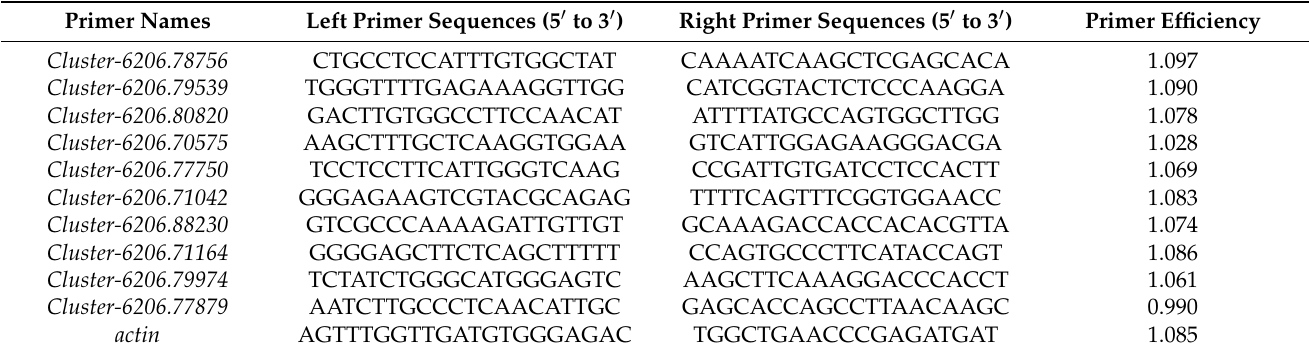
Table 1. Internal reference and real-time PCR gene